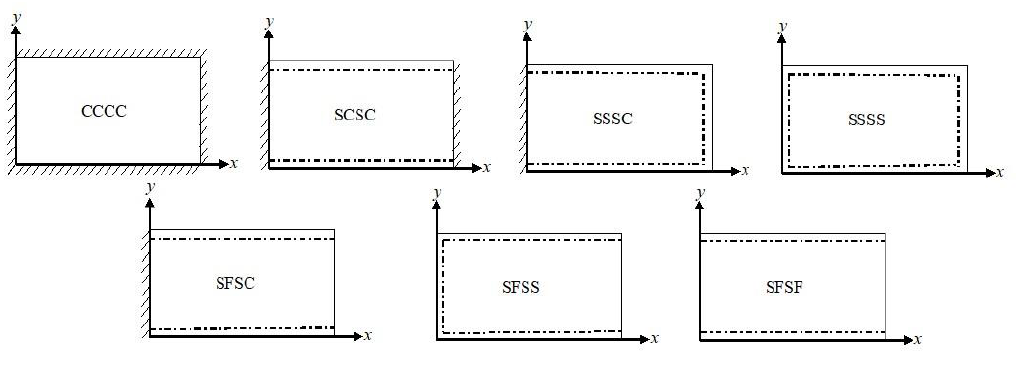
Fig. 4. Boundary conditions nomenclature.